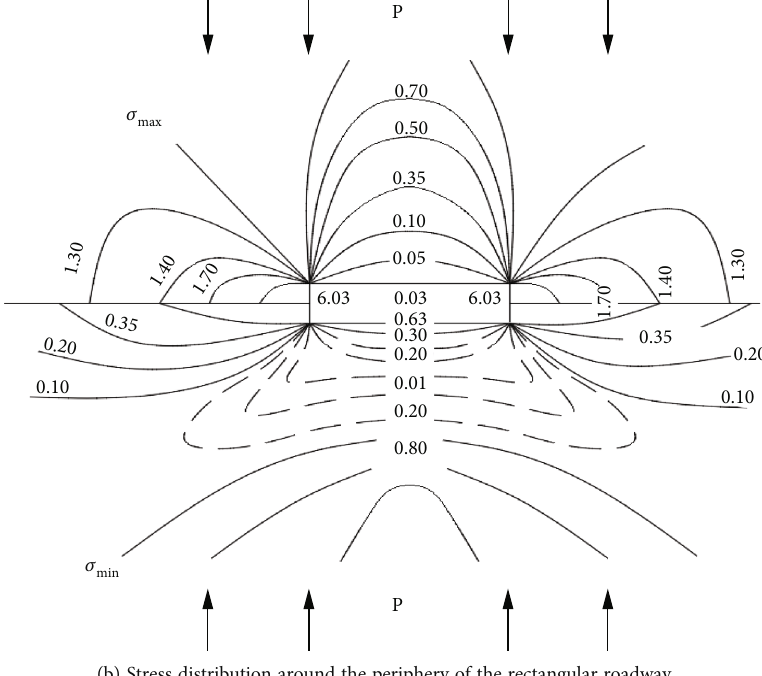
Figure 3: Validation of the numerical